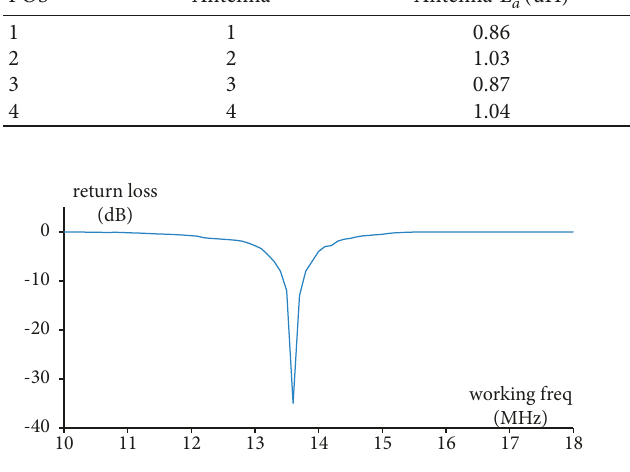
Figure 11: Antenna return loss after impedance